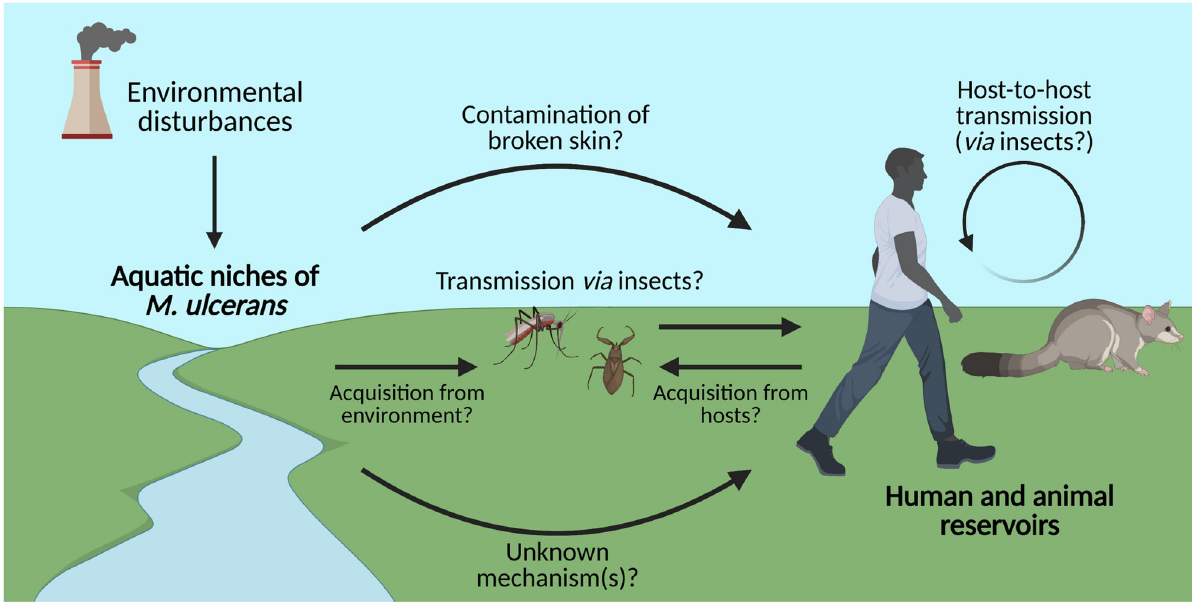
Fig 1. Proposed mechanisms of transmission of Mycobacterium ulcerans , the causative agent of Buruli ulcer. The mode(s) of transmission of Buruli ulcer are still uncertain and are likely to differ between West Africa and Southeast Australia. However, hypotheses such as M . ulcerans contamination via aquatic niches [10], host-to-host transmission between humans and animal reservoirs (including possums) [8], and transmission via insect mechanical vectors (including mosquitoes) [9] have been proposed. These hypotheses are explored in this review. Created with